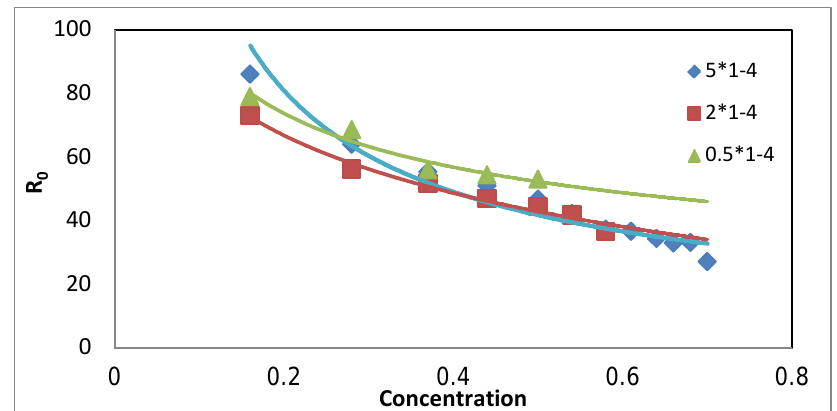
Fig. 9: R as a function of acceptor concentration for different donor o